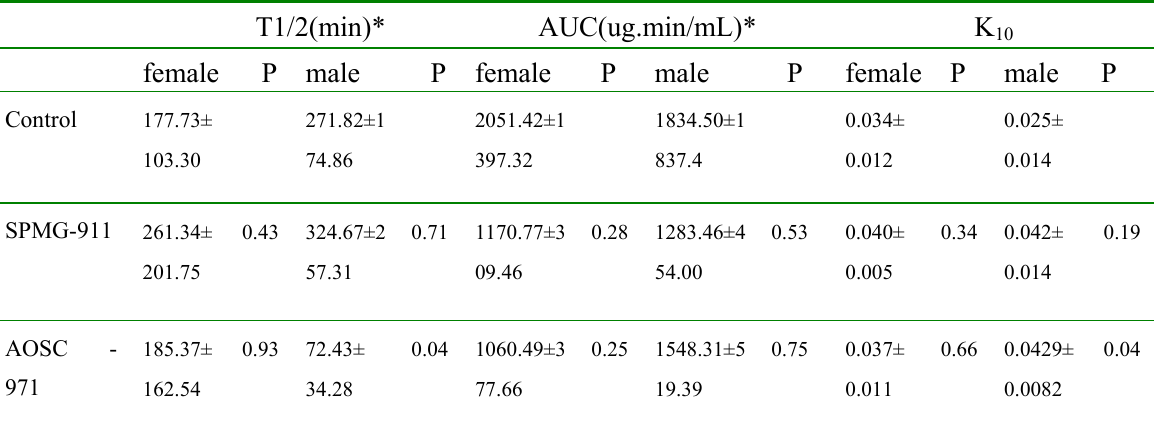
Table 2. Pharmacokinetic Data of Chlorzoxazone ( 5, =± nsx